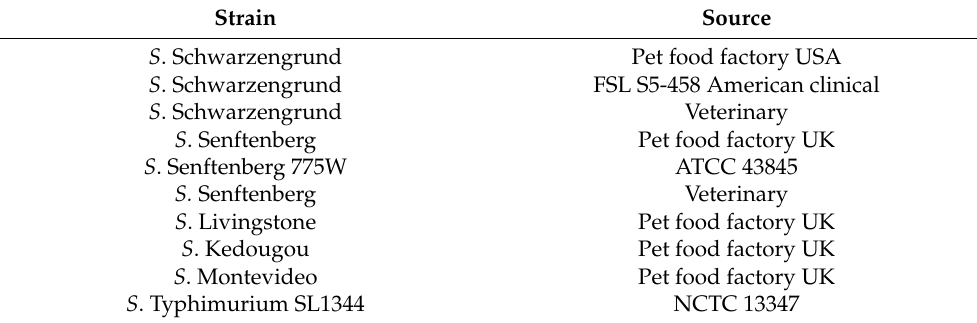
Table 1. Challenge panel of isolates. Strain Source